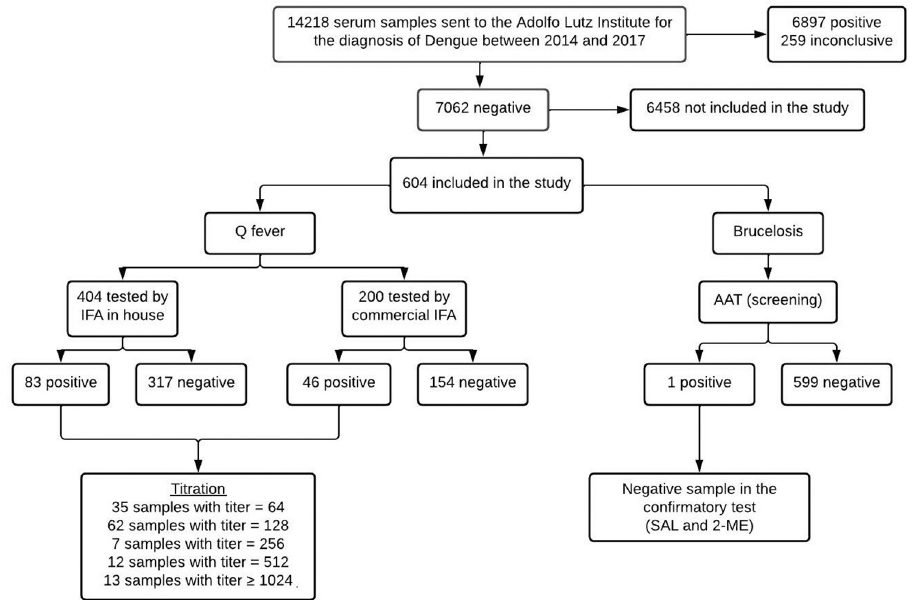
Fig 1. Flowchart of the samples and analysis results of the study.